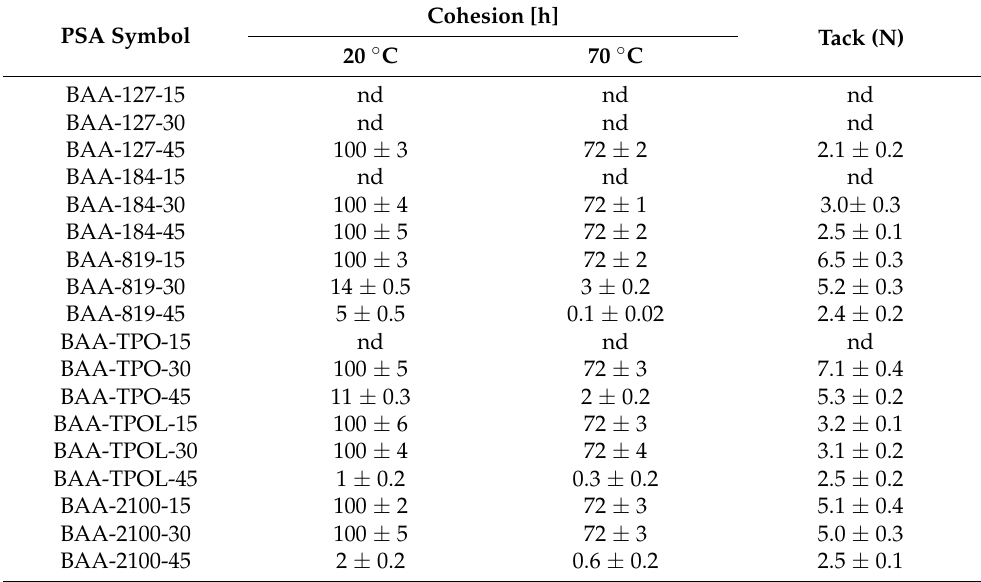
Table 4. Cohesion and tack values of PSAs based on BAA